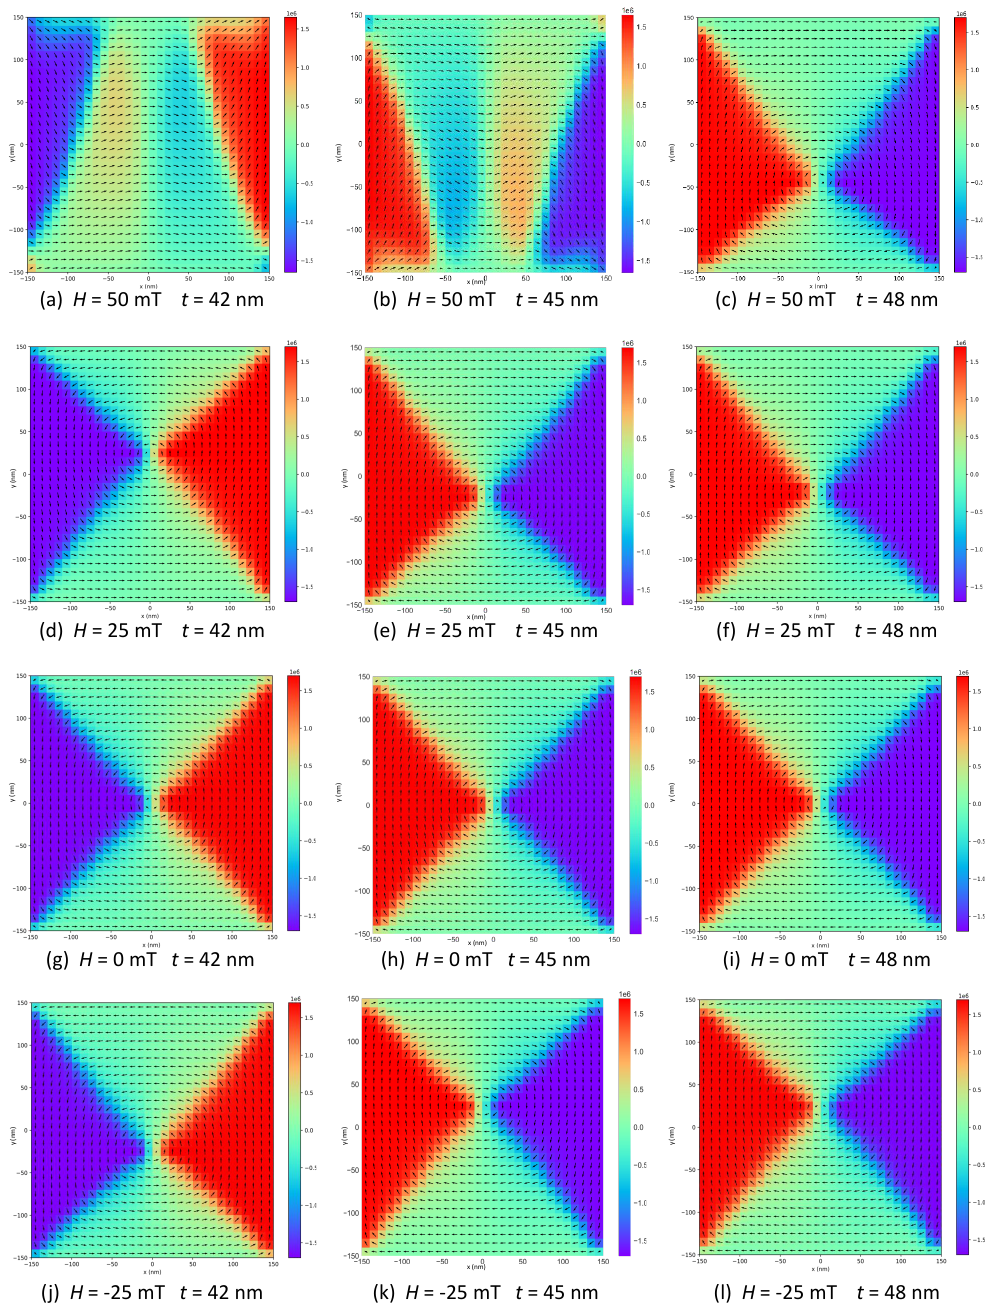
Figure 3. Magnetic configurations for three different thicknesses, namely t = { 42,45,48 } nm (rows), L = 30 nm and four different field values, namely H = { 50,25,0, − 25 } mT